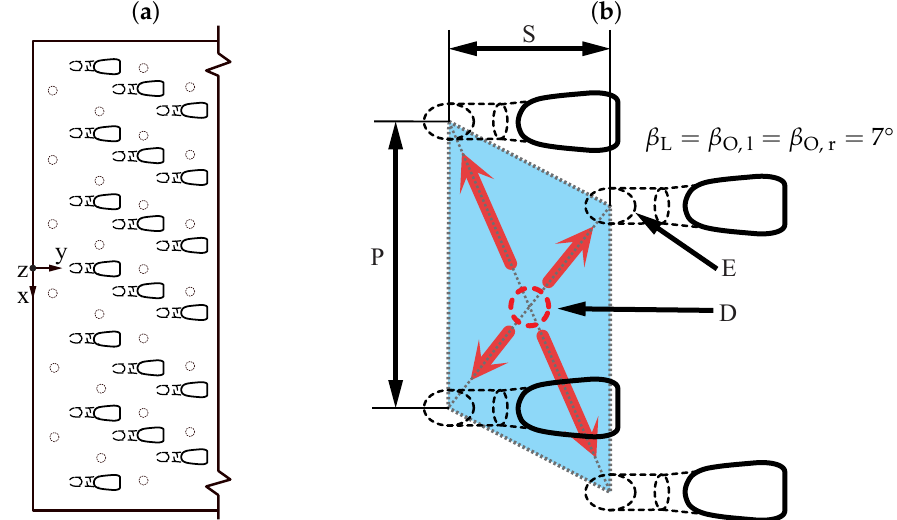
Figure 3. Test specimen geometry. Left, ( a ): Overall arrangement of the cooling holes for effusion and impingement specimen and coordinate frame. Right, ( b ): Arrangement of each impingement cooling hole to the effusion cooling holes. Red arrows show theoretical exit paths and distance to the next effusion cooling hole. The blue parallelogram shows the wetted area before the coolant is ejected. Both arrangements shown for S y =